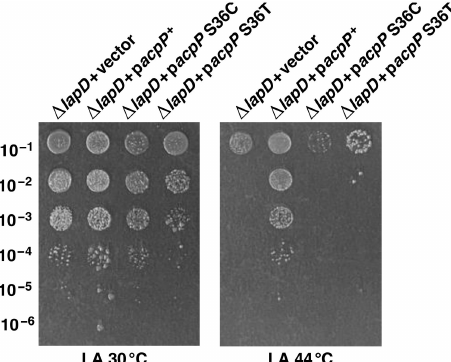
Figure 16. Multicopy suppression of ∆ lapD bacteria by the acpP gene requires its product to retain its active site Ser 36 amino acid residue. Growth of isogenic cultures of ∆ lapD bacteria transformed with either plasmid DNA of the vector alone or with plasmids carrying the wild-type acpP gene or its active site variants. The expression of the acpP gene is induced by the addition of 0.05% arabinose. Bacterial growth was quantified by a spot-dilution assay on LA at 30 and 44 ◦ C. The relevant genotype and temperature of incubation are